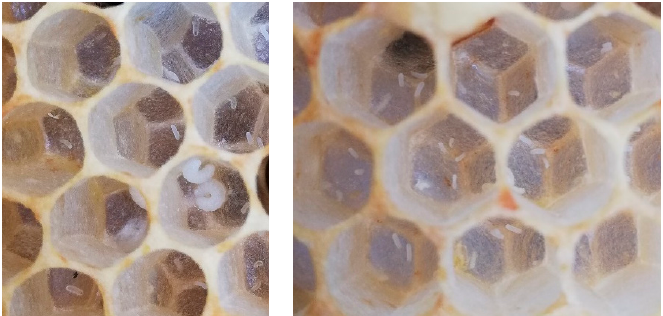
Figure 4. Close-ups of a drone brood comb of colony 2 with more than one egg or larvae per cell, ©Julia Dittes.